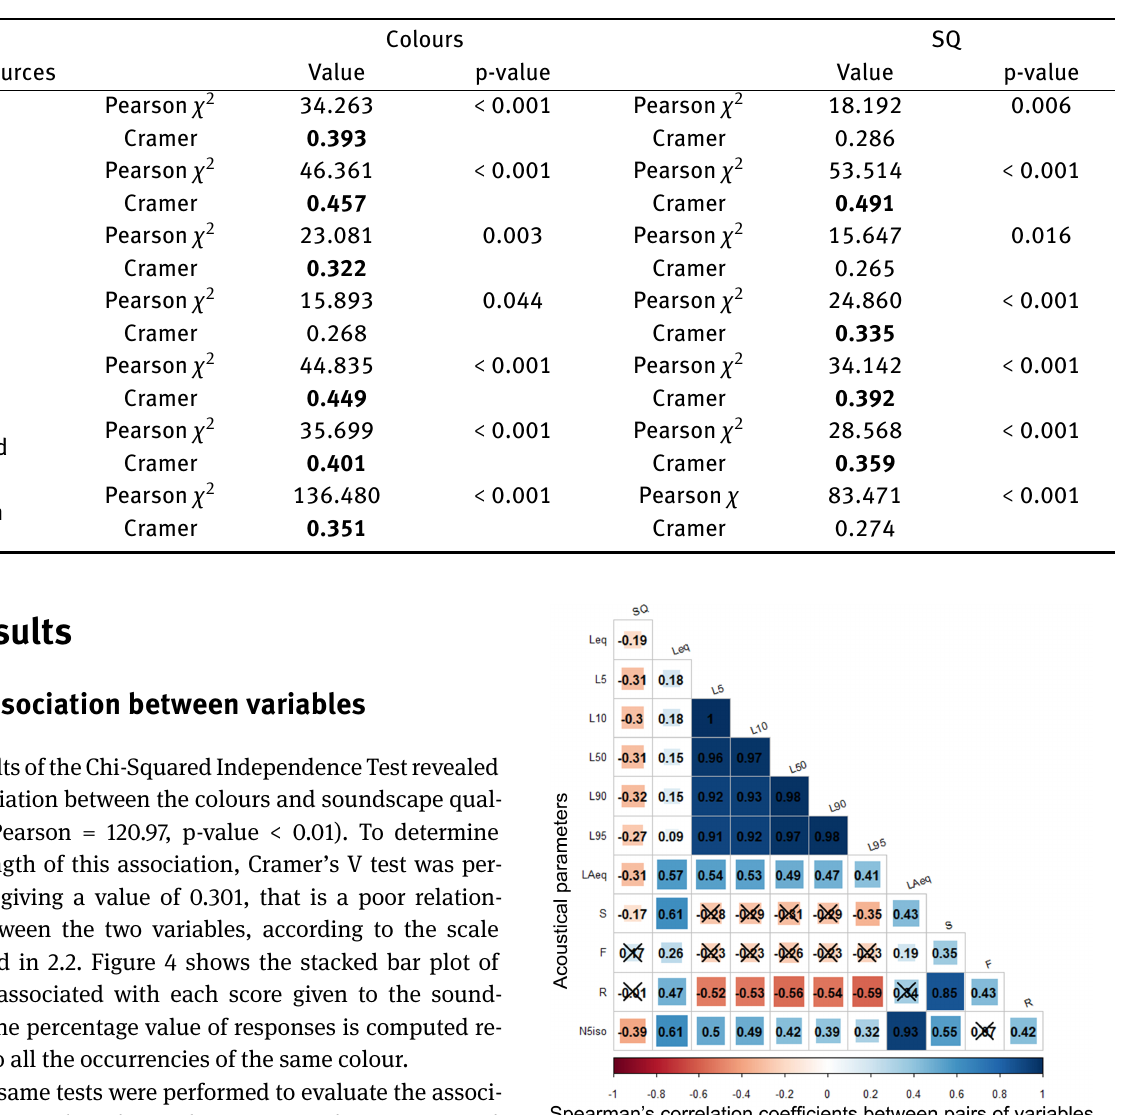
Table 2: Association between colours and soundscape quality (SQ) with the heard (_Sel) and predominant (_Pred) sound sources. Only the pair of variables with p-value in the Chi-square test lower than 0.05 are reported (See Table 1 for abbreviations).